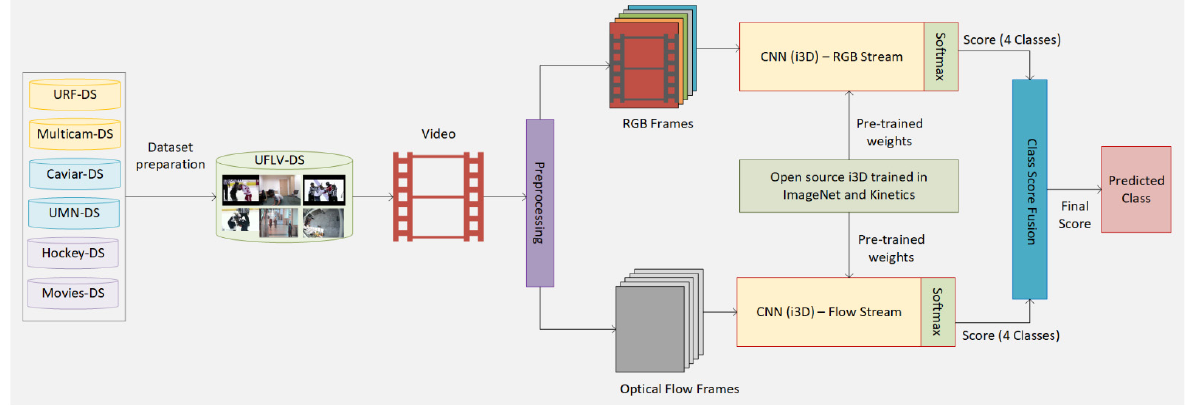
Figure 1. Overall system architectural flow.